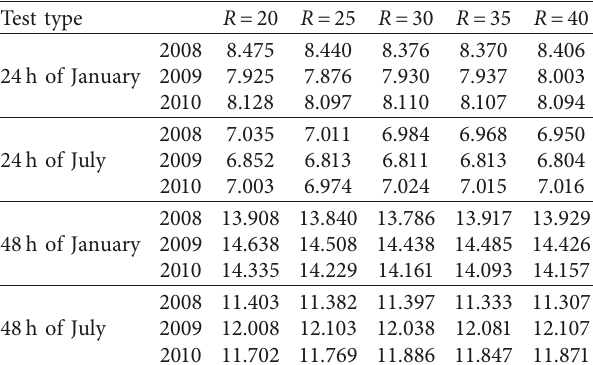
Table 2: Average of RMSE of geopotential height on 500hPa after correction of nonsystematic error for test samples with different truncation orders (unit: